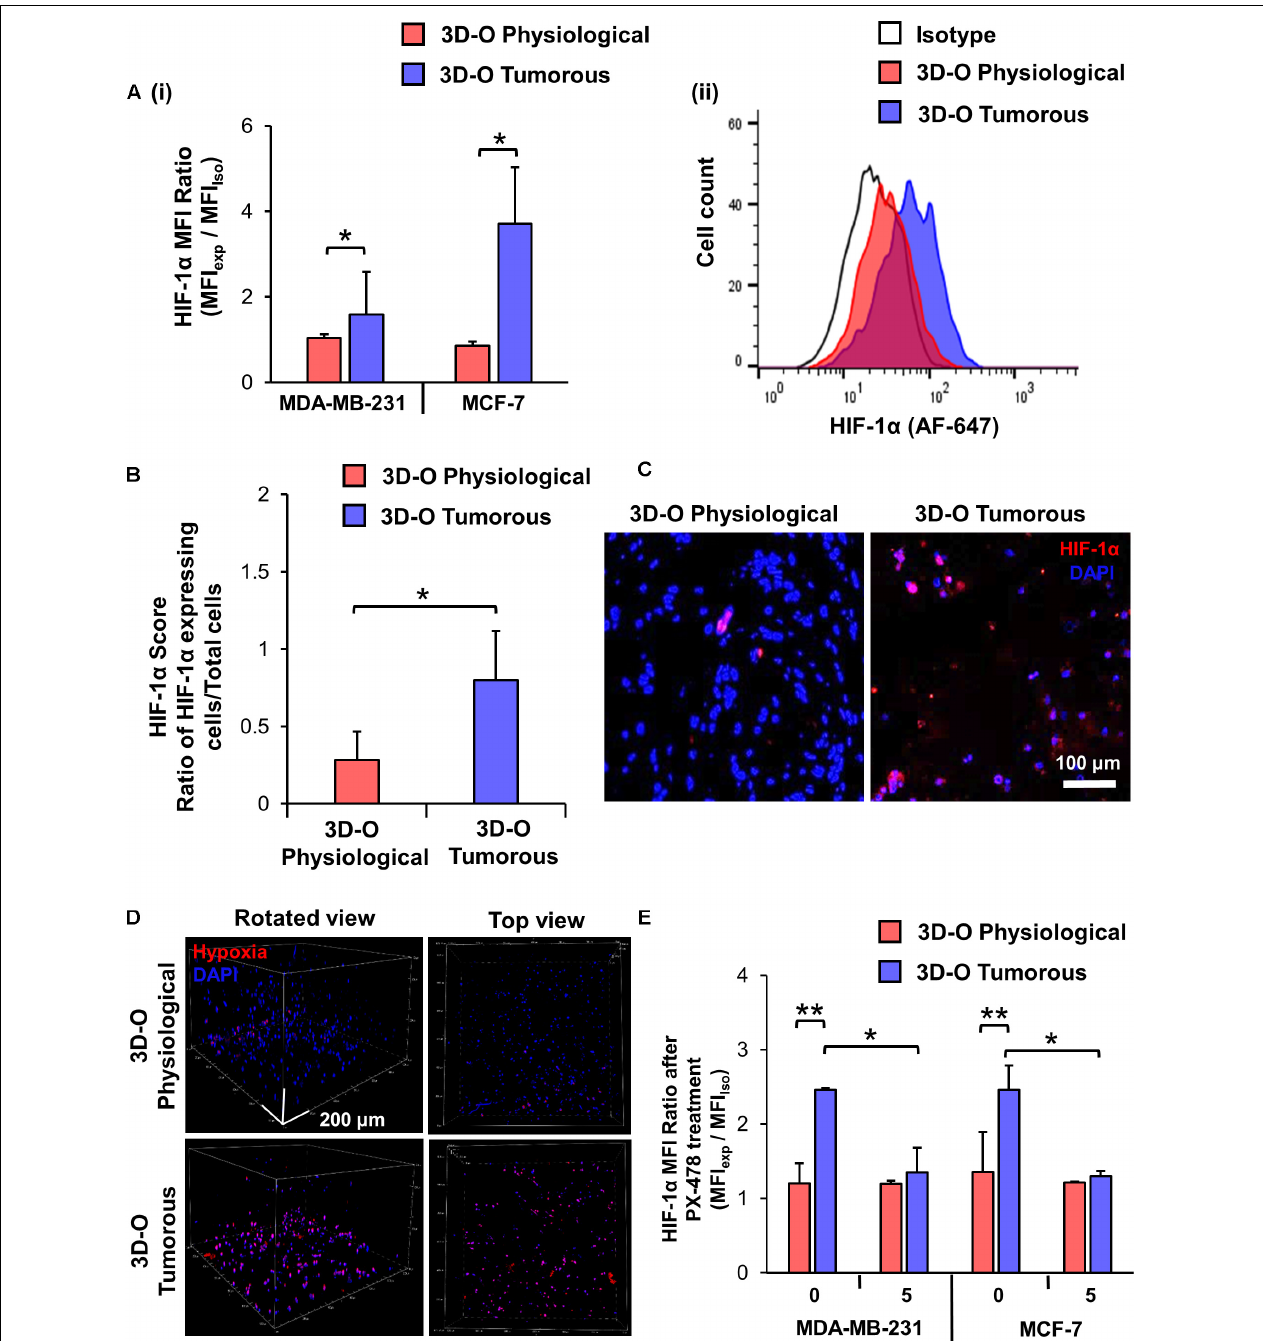
FIGURE 2 | Validation of hypoxic phenotype in 3D-O matrices. (A) HIF-1 α expression by MDA-MB-231 and MCF-7 cells grown in 3D-O physiological and 3D-O tumorous matrices after 4 days quantified as MFI ratio between AF647-anti-HIF-1 α and AF647 isotype control (i) and flow cytometry representative histogram (ii) . (B) Mean HIF-1 α score indicating the percentage of MDA-MB-231 cells positive for HIF-1 α expression after 4 days in 3D-O physiological and 3D-O tumorous matrices. (C) Representative fluorescent imaging at day 4 for MDA-MB-231 cells grown within 3D-O physiological and 3D-O tumorous; DAPI: Blue; HIF-1 α : Red. Merged: Pink. Scale bar = 100 µ m. (D) A hypoxia-sensing dye was added to both 3D-O physiological and 3D-O tumorous matrices containing MDA-MB-231 cells on day 4. After 2 h, scaffolds were imaged using confocal microscopy to monitor hypoxia fluorescence marker associated with the BCa cells. Representative fluorescent images of z-stack images at day 4 for MDA-MB-231 cells grown within 3D-O physiological and 3D-O tumorous; DAPI: Blue; Hypoxia reagent: Red). Scale bar = 200 µ m. (E) HIF-1 α expression for MDA-MB-231 and MCF-7 cells after treatment with PX-478 at 5 µ M concentration quantified as MFI ratio between AF647-anti-HIF-1 α and AF647 isotype control in 3D-O physiological and 3D-O tumorous matrices after 4 days. ** p < 0.001, * p < 0.05, data were analyzed using unpaired two-tailed Student’s t -test.